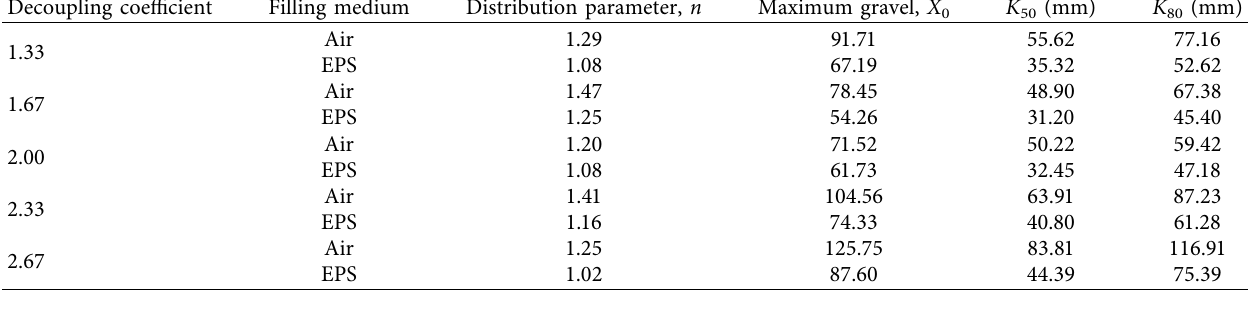
Table 8: Statistical analysis of the block distribution of macadam.